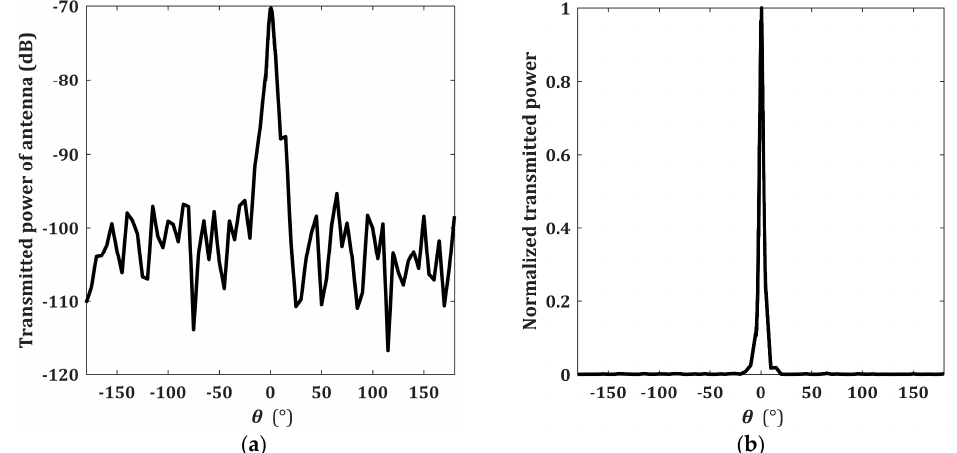
Figure 4. ( a ) The transmitted power of Tomoradar antenna ( P dB ) in the unit of dB [28]; ( b ) the normalized transmitted power of Tomoradar antenna in Equation (3): P t ( θ ) = 10 PdB /10 point of θ corresponds to the axial center of microwave radiation, and the sign of θ is same as that of X l in Equation (4). The angular separation in the main lobe is close to 20 ◦